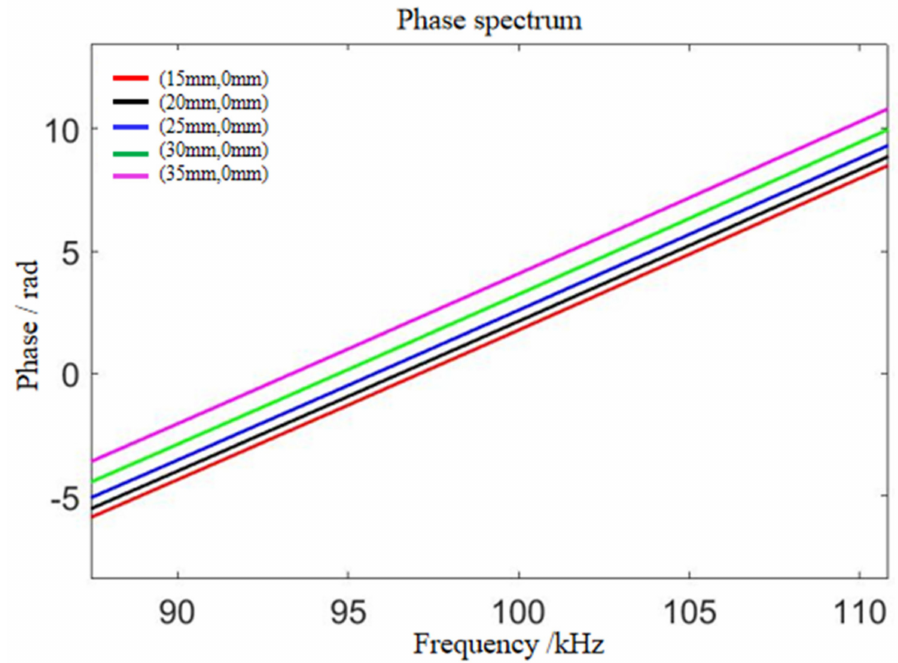
Figure 6. Phase spectrum of the damage scattering signal on the x